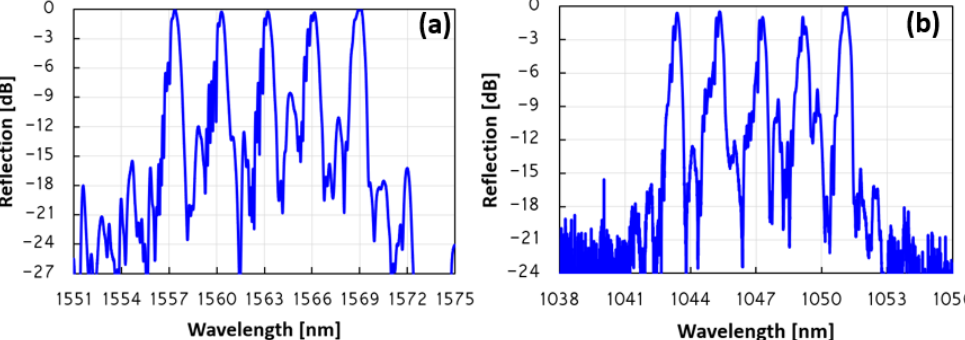
Figure 4. Measured reflection spectra of the final five FBG array. ( a ) The five transmission peaks are clearly visible at a wavelength of 1569.07 nm, 1566.17 nm, 1563.22 nm, 1560.29 nm 1557.37 nm. The ~2.9 nm separation between each two consecutive neighboring FBGs is clearly visible as well as the 11.7 nm separation between the first FBG and the last one. ( b ) The measured reflection spectra of the third-order Bragg of the five FBG array. The center Bragg wavelength of the five peaks and the ~1.9 nm separation between each two consecutive FBGs is clearly visible. All five peaks are approx- imately 20 dB above the background.